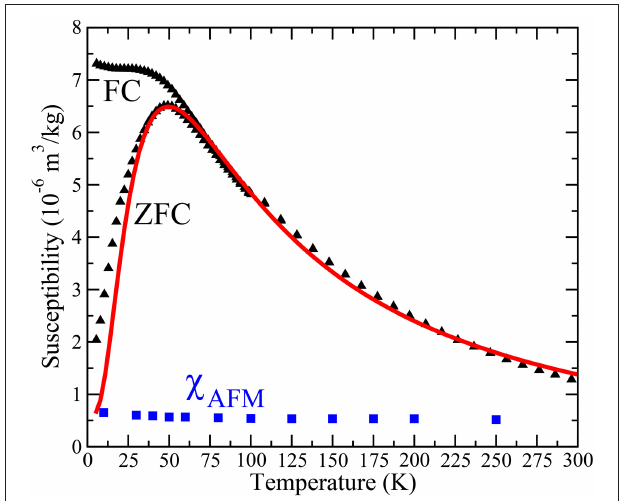
FIGURE 9 | Low-temperature alternative current ( ac ) magnetic susceptibility curves ( χ ′ ). The out-of-phase magnetic susceptibility ( χ ′′ ) is displayed in the